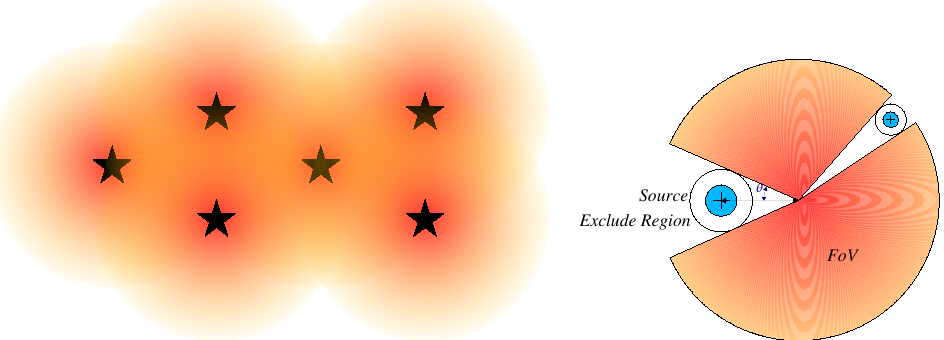
Figure 7. ( Left ) Stacking of background models for a data set with different pointing. ( Right ) Radial acceptance determination in the presence of known or putative γ -ray sources.